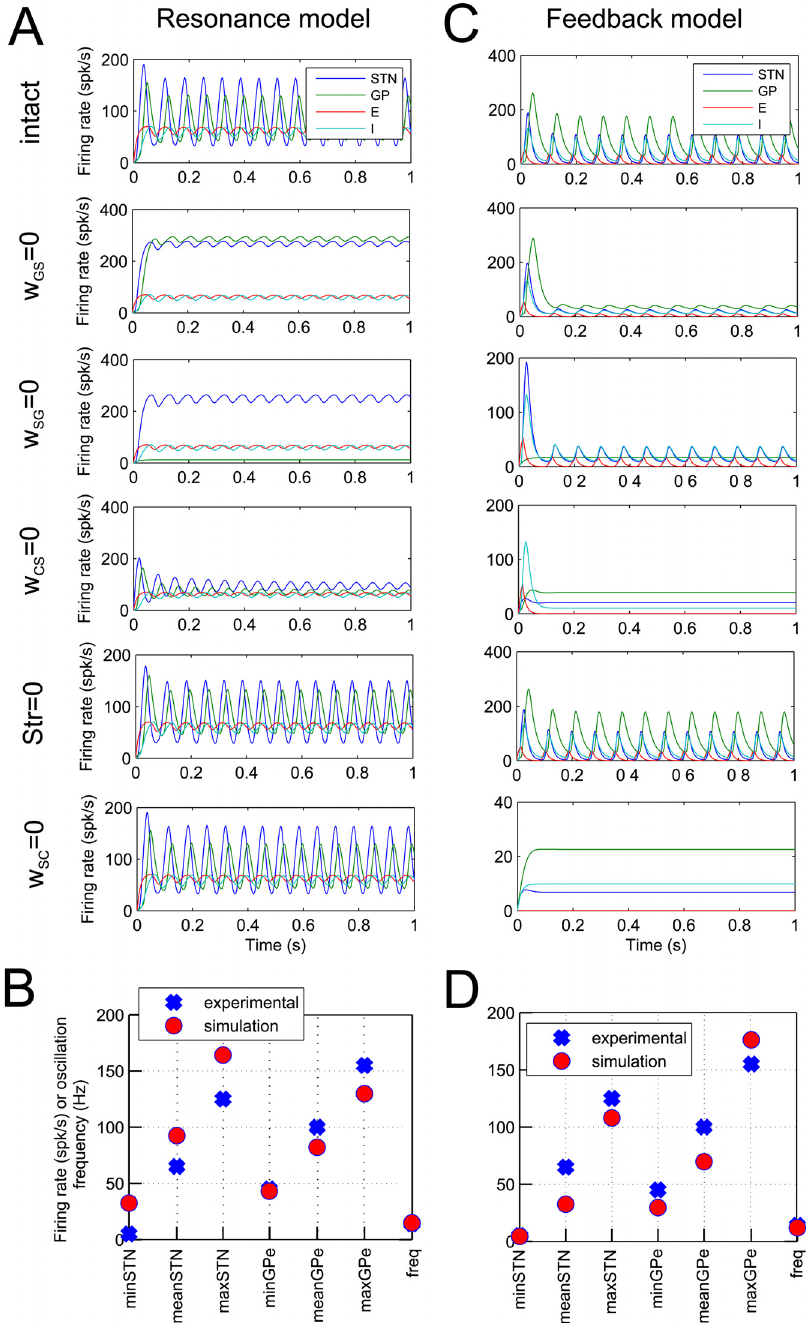
Fig 3. Results of simulations of the resonance model (panels A and B) and feedback model (panels C and D). A, C) Each of the six panels shows the activity of the STN, GPe and cortical populations as a function of time. The labels to the left indicate if a row shows simulations of an intact model, or a model with particular connections blocked. In simulations in panel A the following parameters were used: w SG = 4.87, w GS = 1.33, w CS = 9.98, w SC = 8.93, w GG = 0.53, w CC = 6.17, C = 172.18, Str = 8.46, T CC = 4.65, τ E = 11.59, τ I = 13.02, B E = 17.85, B I = 9.87, M E = 75.77 and M I = 205.72. In simulations in panel C the following values were used: w SG = 2.56, w GS = 3.22, w CS = 6.60, w SC = 0.00, w GG = 0.90, w CC = 3.08, C = 277.94, Str = 40.51, T CC = 7.74, τ E = 11.69, τ I = 10.45, B E = 3.62, B I = 7.18, M E = 71.77 and M I = 276.39. B, D) The comparison between experimental and simulated statistics of the